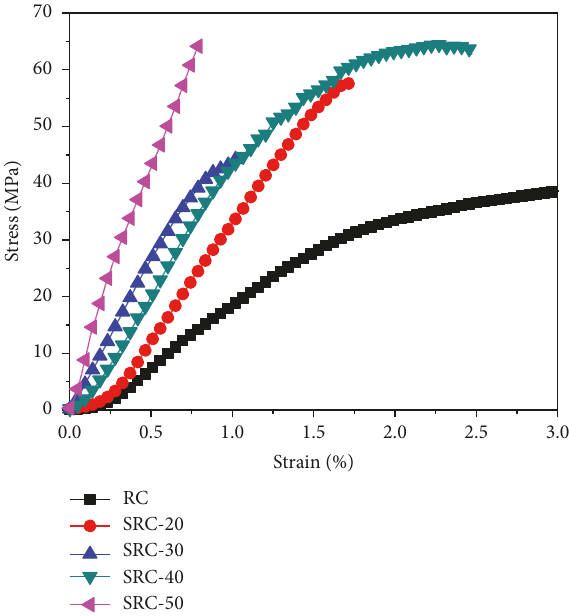
Figure 6: The stress-strain curves of the films prepared with RC dispersion and SRCs; the solid content of the dispersions for the preparation of the films was control to 1.2